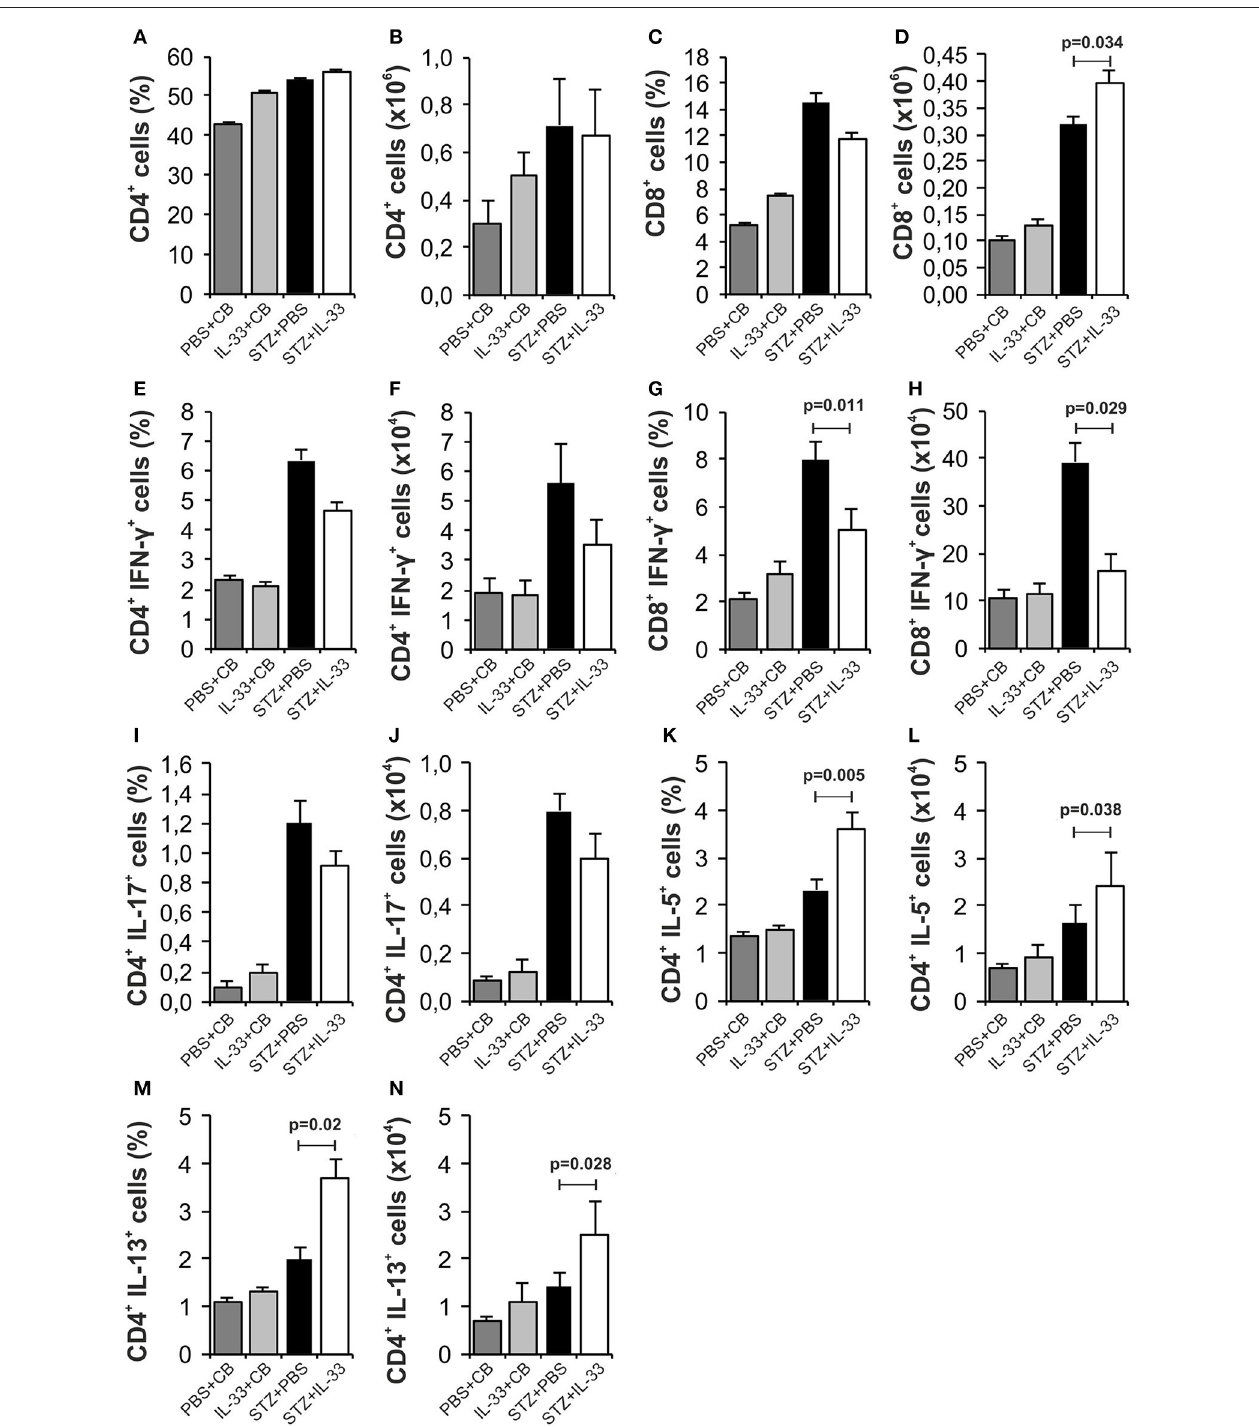
FIGURE 2 | IL-33 attenuates inflammatory cells and increases IL-5 and IL-13 producing CD4 + cells. The percentage and total number of CD4 + (A,B) , CD8 + (C,D), CD4 + IFN- γ + ( E,F) , CD8 + IFN- γ + (G,H), CD4 + IL-17 + (I,J) , CD4 + IL-5 + (K,L) , CD4 + IL-13 + (M,N) were examined. The animals were treated with 0.4 µ g/injection IL-33 together with MLD-STZ (i.p. 40 mg/kg for 5 consecutive days) or of an equimolar dose of PBS or 0.4 µ g/injection IL-33 together with citrate buffer. Cells were obtained from pancreatic lymph nodes on day 28 after diabetes induction. Data from two individual experiments with at least 8 mice per group are shown as mean ± SEM; by paired t -test when compared with values obtained with phosphate-buffered